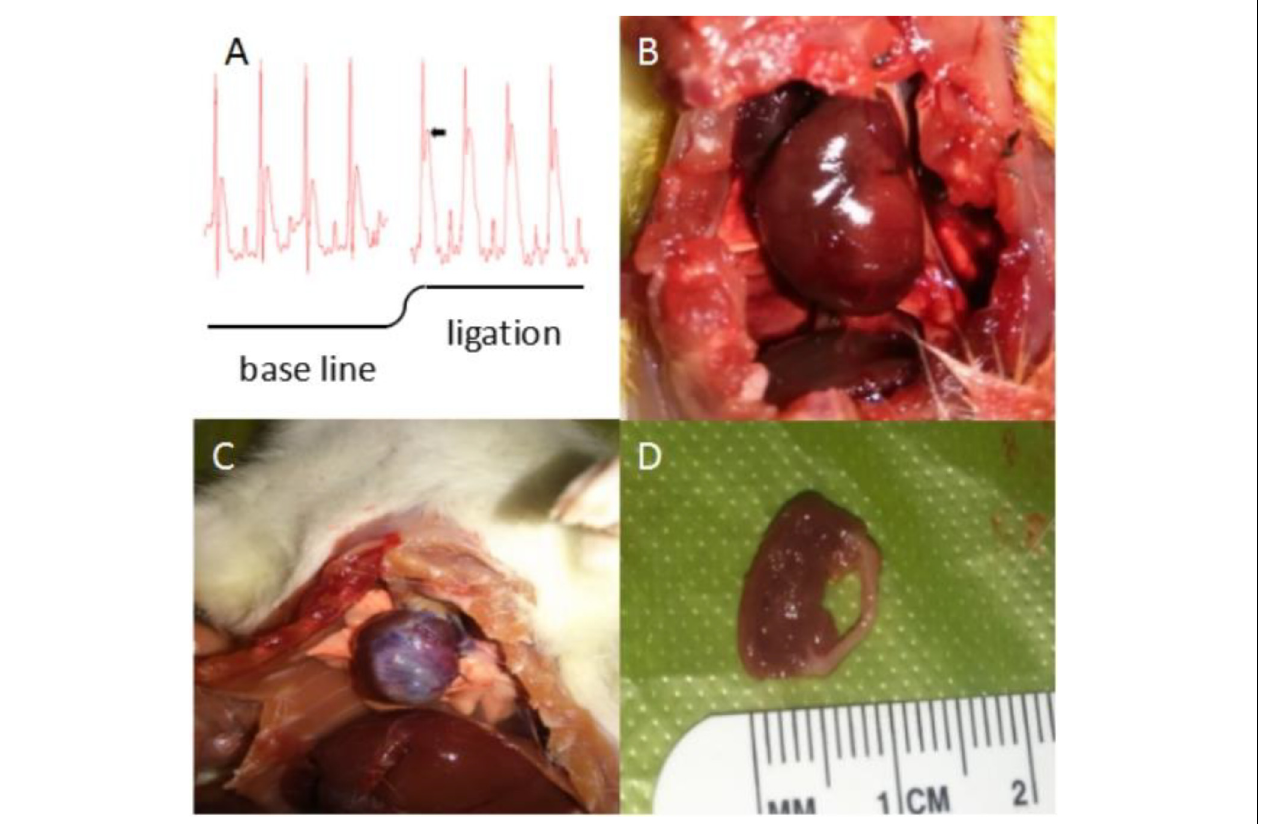
FIGURE 10 | Physical features of rat hearts after coronary artery ligation (CAL). (A) Classic significant S-T segment elevation ( (cid:49) S-T segment > 0.1 mV is the criteria for myocardial infarction) by ECG appeared immediately when the left anterior descending coronary artery was ligated. (B) Ischemic pale-turning at the local precordia was visible to the unaided eye after a few minutes of CAL. (C) After 10 weeks, the rat hearts exhibited different degrees of fibrosis. Large-scale cardiac fibrosis of praecordia was distinctly observed, even spreading to apex of the heart and the whole heart shrunk to smaller. (D) Dissection of the hearts into cross-sections revealed that the ventricular wall of the left heart was thinning, and myocardial tissue was replaced by